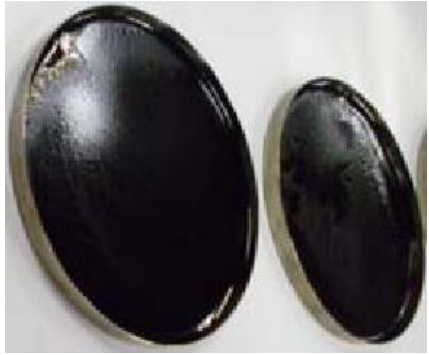
Figure 2. Asphalt sample.